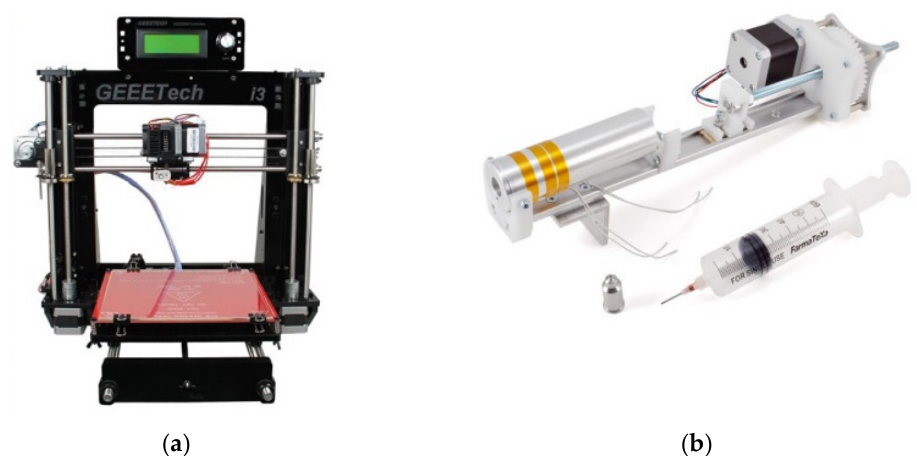
Figure 1. The hydrogel printing system: ( a ) the original thermoplastic printer; ( b ) the fluid extrusion add-on.